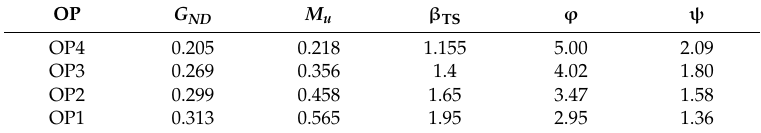
Table 4. Non-dimensional flow quantities for OP1-4 (reference diameter = 350